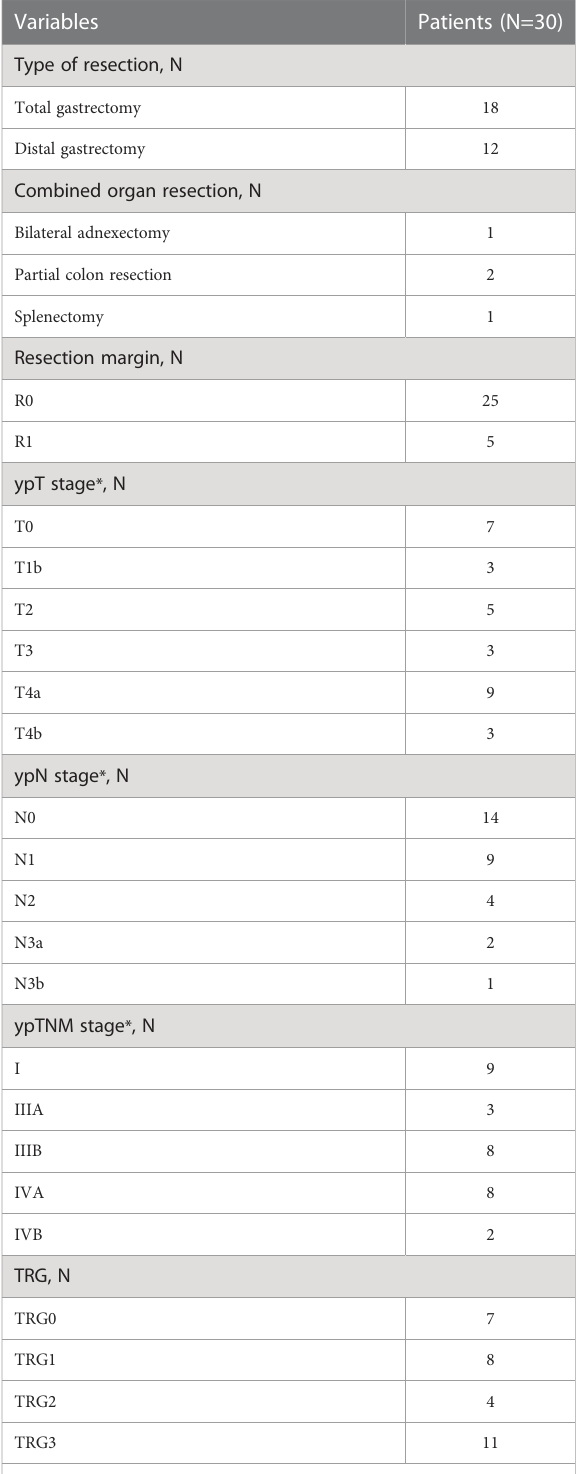
TABLE 2 Surgical and pathological